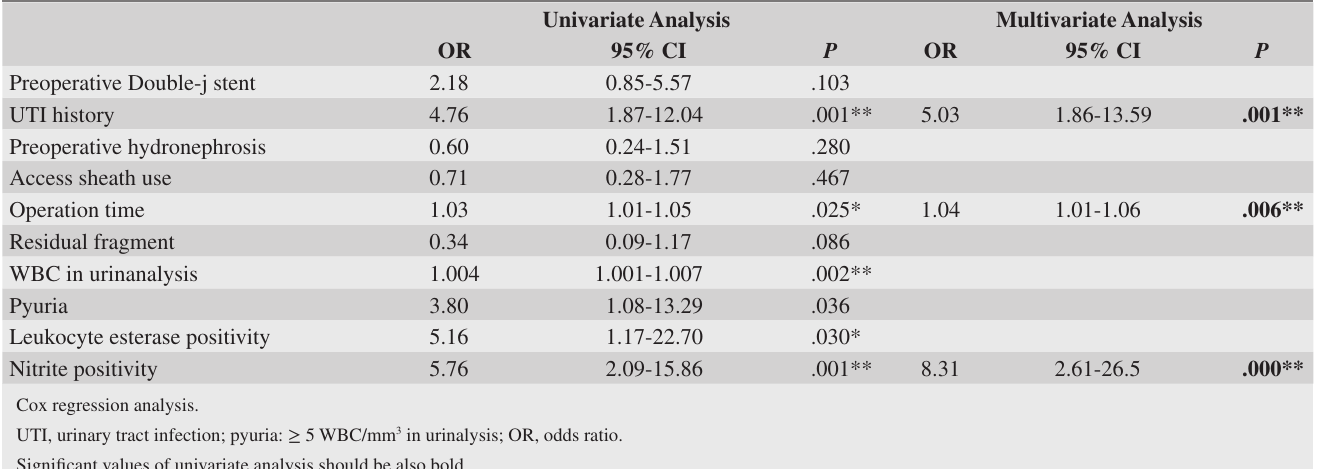
Table 4. Factors Associated with Postoperative UTI—Univariate Versus Multivariate